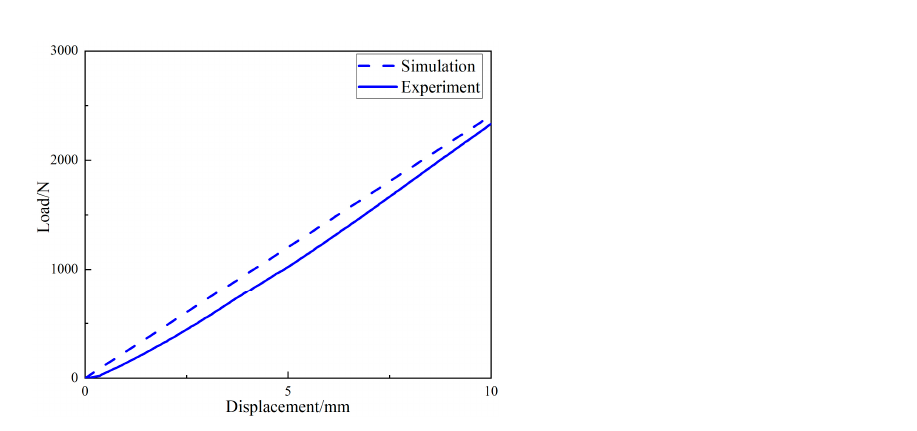
Figure 25. Comparison of load–displacement curve between simulation and experiment.